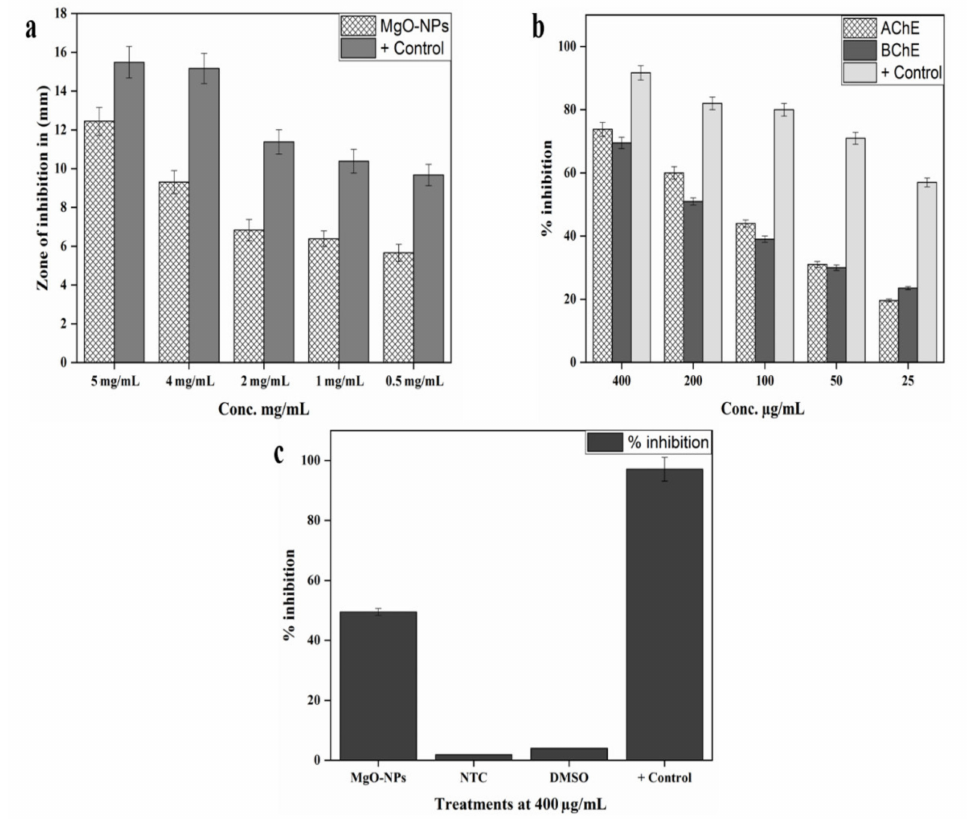
Figure 6. ( a ) Protein kinase inhibition, ( b ) in vitro AChE and BChE inhibition, ( c ) Anti-cancer potential of MgO-NPs against Hela Cell Lines.